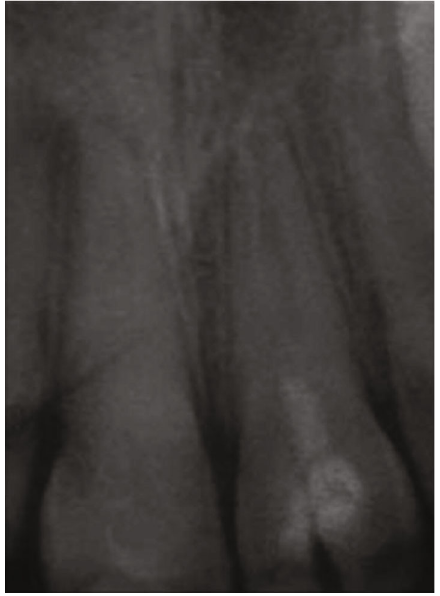
Figure 6: 6-month follow-up radiograph after revascularization: thickening of the wall with the beginning of root calci fi cation on